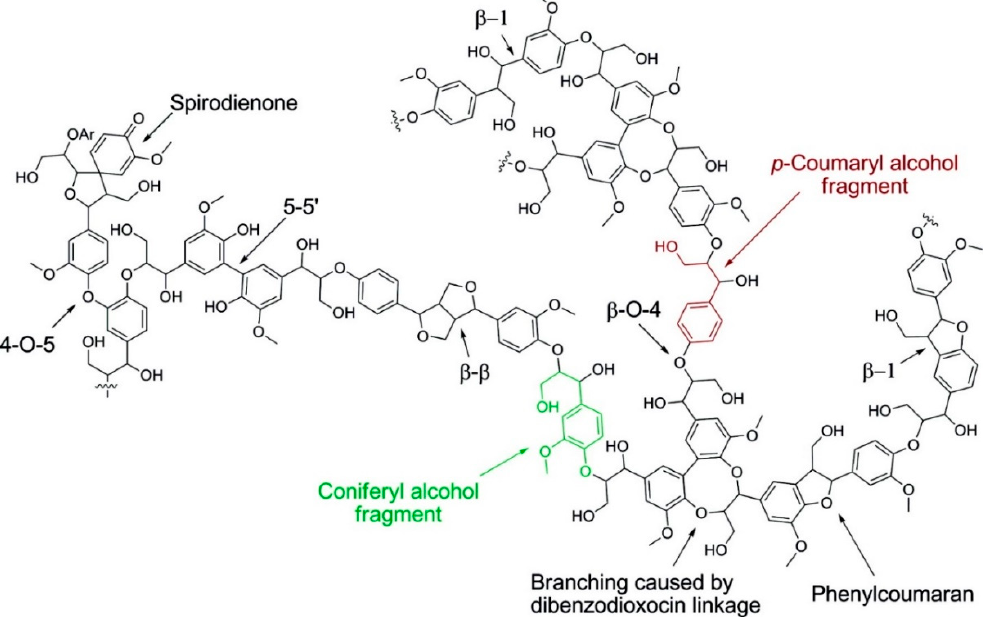
Figure 3. A schematic representation of softwood lignin structure. Reproduced with permission [12].